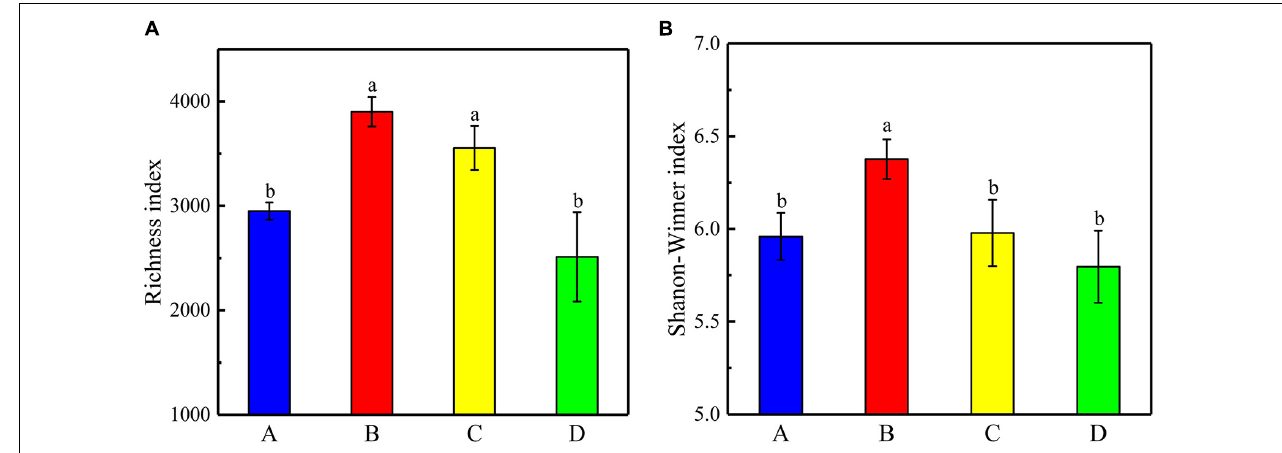
FIGURE 5 | (A) Shannon–Winner indices and (B) the richness indices of OTUs for all samples at the different sites. Error bars indicate standard error of the mean ( n = 3). The symbols represent different levels of significance at p < 0.05 for the sites.